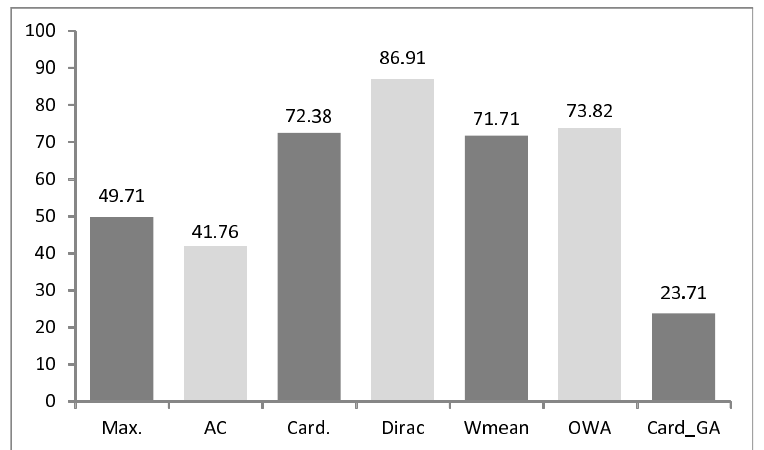
Figure 3. Rankings of the seven approaches considered in the study.